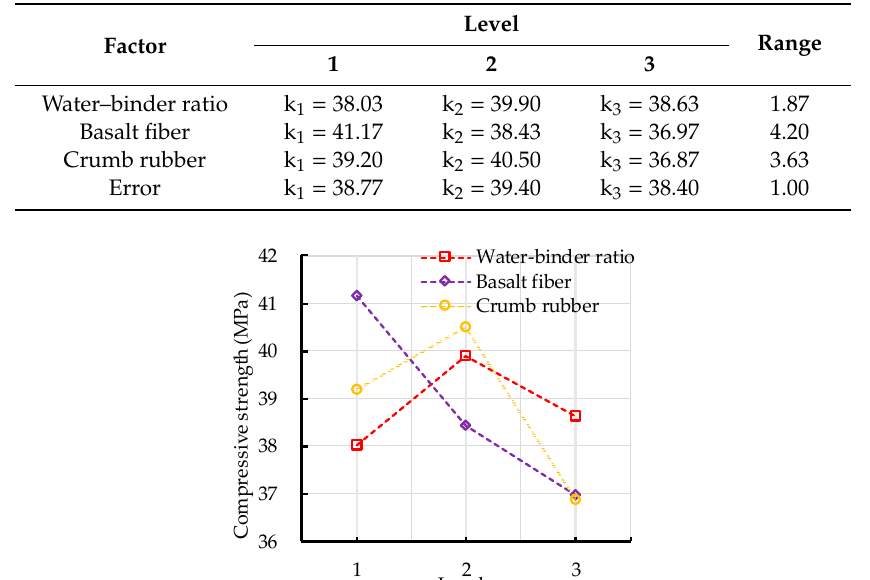
Table 8. Range analysis for compressive strength of CRBFC.